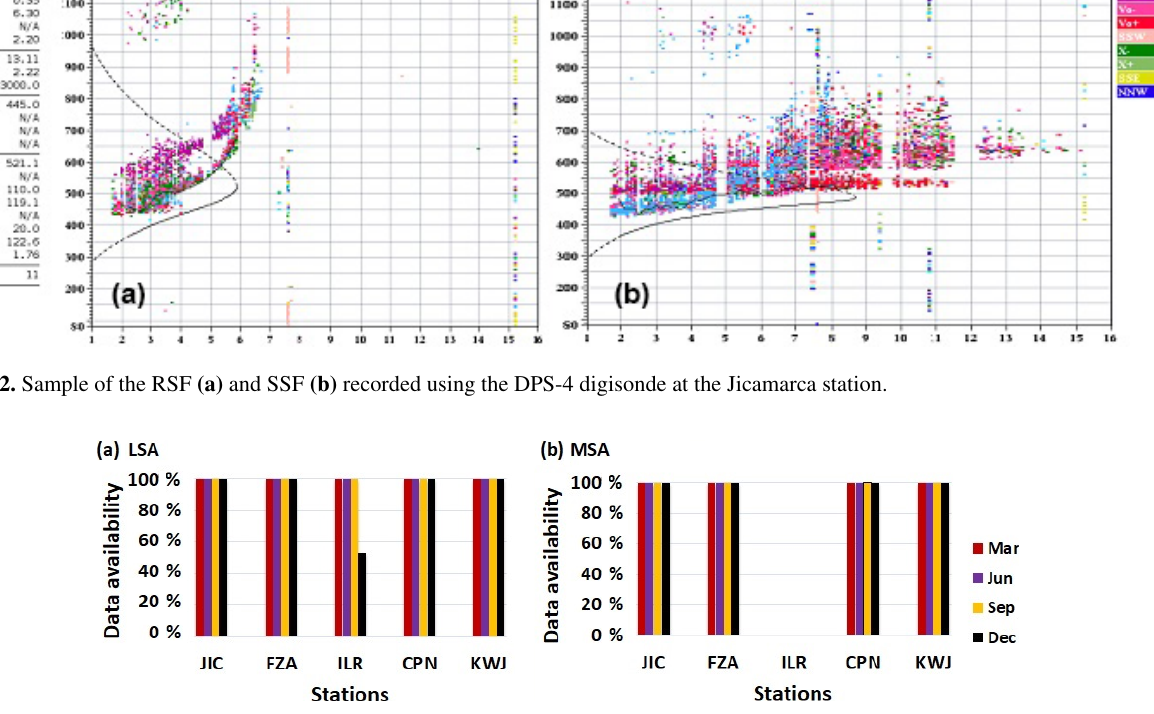
Figure 3. The ionogram data availability at the Jicamarca (JIC), Fortaleza (FZA), Ilorin (ILR), Chumphon (CPN) and Kwajalein (KWJ) stations during the (a) LSA and (b) MSA